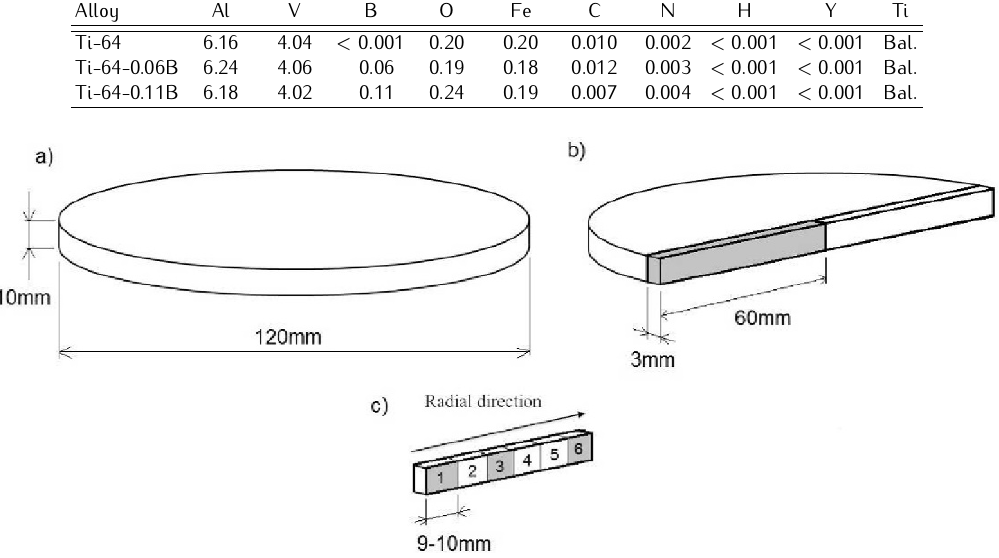
Figure 1. Schematic illustration of samples used for microstructural characterisation: (a) ingot slice; (b) location and position of the specimens that were removed from the ingot slice and used for metallographic examination; (c) the specimens in (b) were divided into six areas with area designations as 1-edge, 3-middle, and 6-center, with respect to the